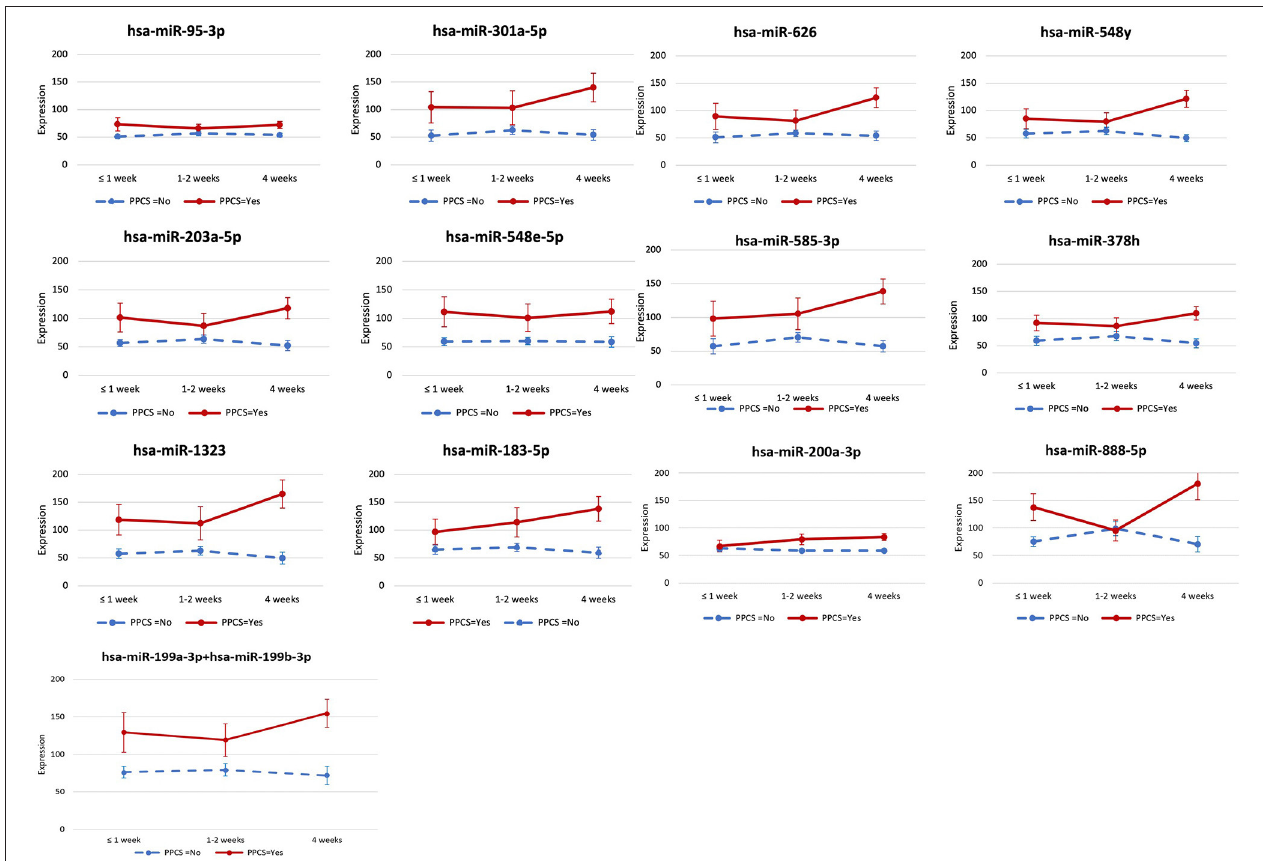
FIGURE 1 | miRNA expression levels between concussed children with and without persistent post-concussive symptoms (PPCS) across the three timepoints post-injury. We identified 13 miRNAs whose expression levels were significantly higher across the three timepoints post-injury in concussed children with PPCS compared to those without PPCS. In this graph, we show the longitudinal expression levels of each miRNA at the three timepoints in concussed children with PPCS (red) vs. concussed children without PPCS (blue) without adjusting for any